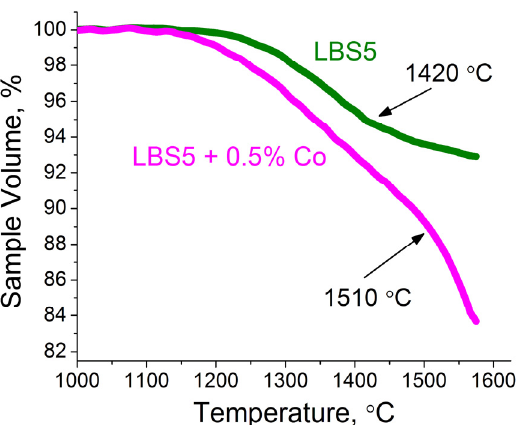
Figure 5. Shrinkage of La 0.95 Ba 0.05 ScO 3- δ and La 0.95 Ba 0.05 ScO 3- δ + 0.5 wt% Co 3 O 4 samples during sintering according to optical dilatometry analysis.